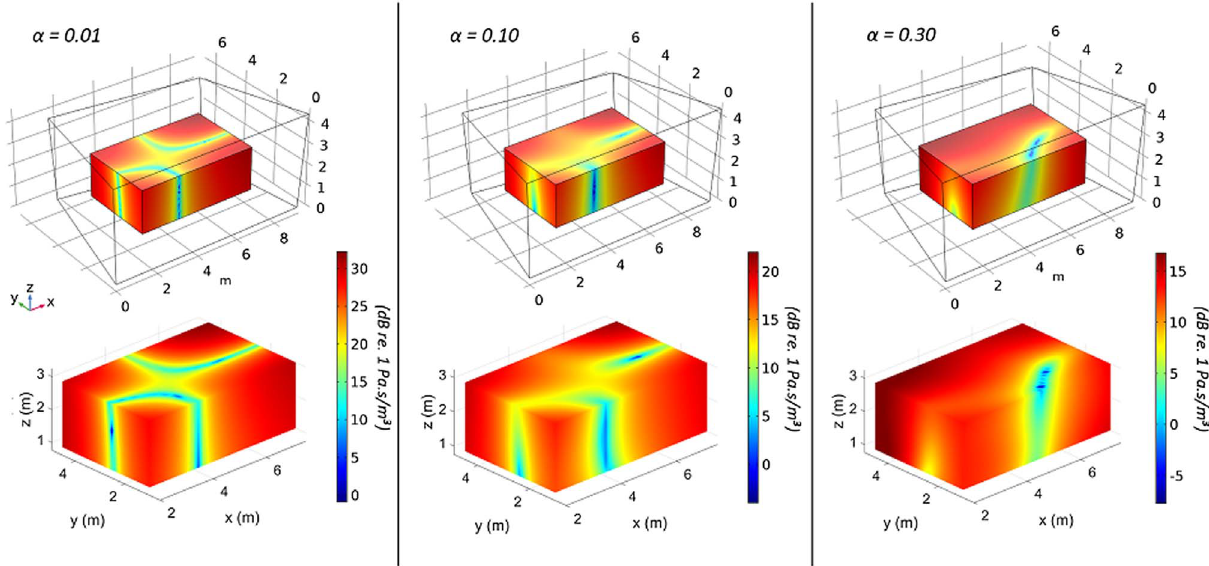
Figure 7. Sound fi eld reconstruction (bottom) compared to the reference (top) for different cases of wall damping ( a = 0.01, 0.10, and 0.30 from left to right) at the eigenfrequency around 35.3 Hz.